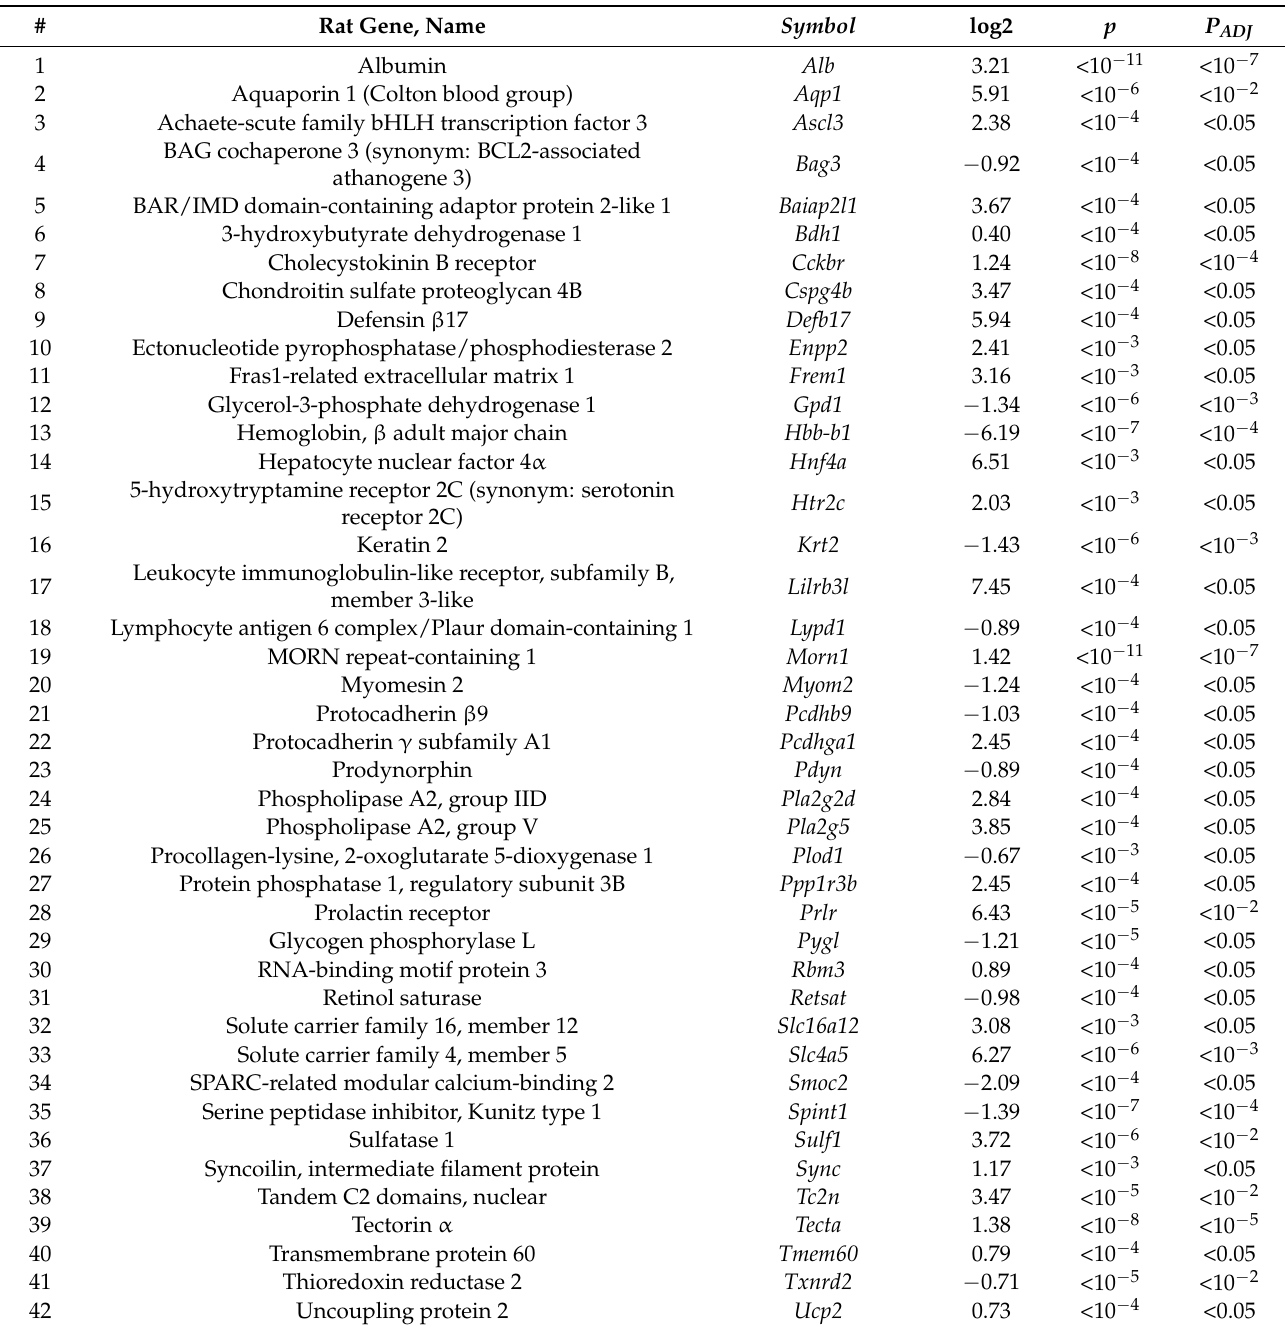
Table 2. The statistically significant DEGs in the hippocampus (of tame versus aggressive adult male rats) that were for the first time unidentified in this